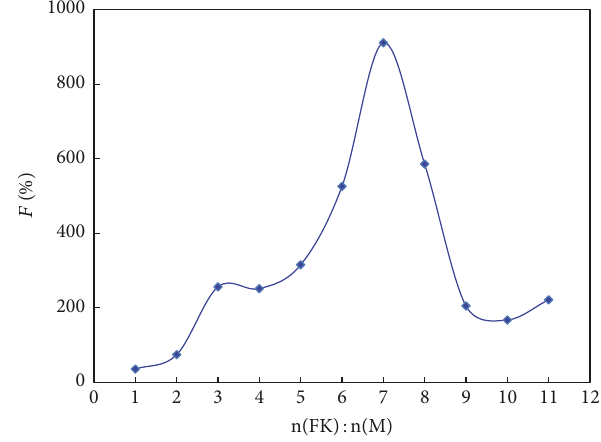
Figure 10: O 2∙− scavenging activity of FK-GlyCu 𝑥 with different ratios.